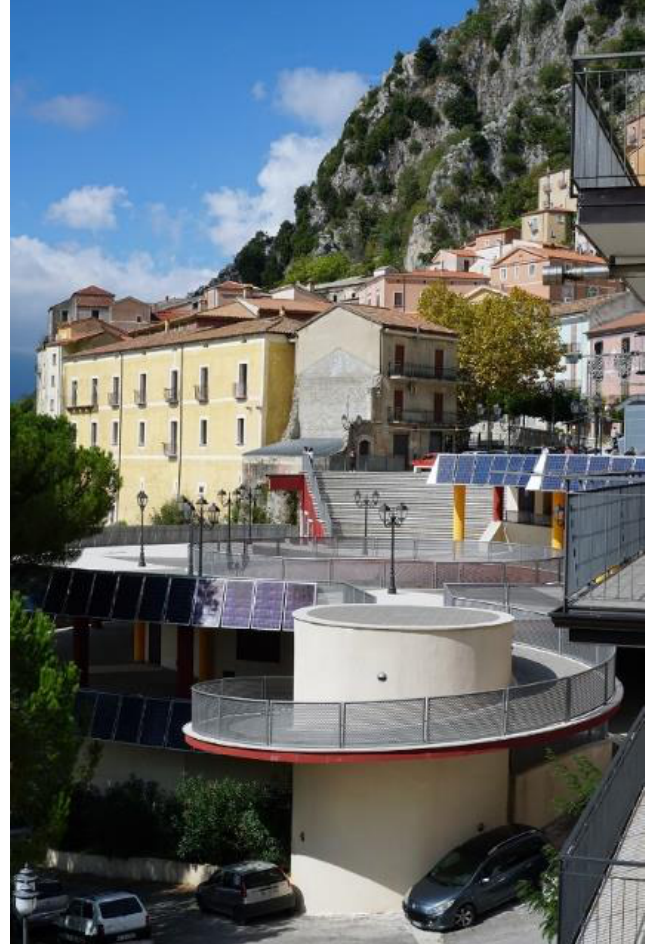
Figure 82. Colliano: New parking area of the Epifani Square (photos by [35,36]).